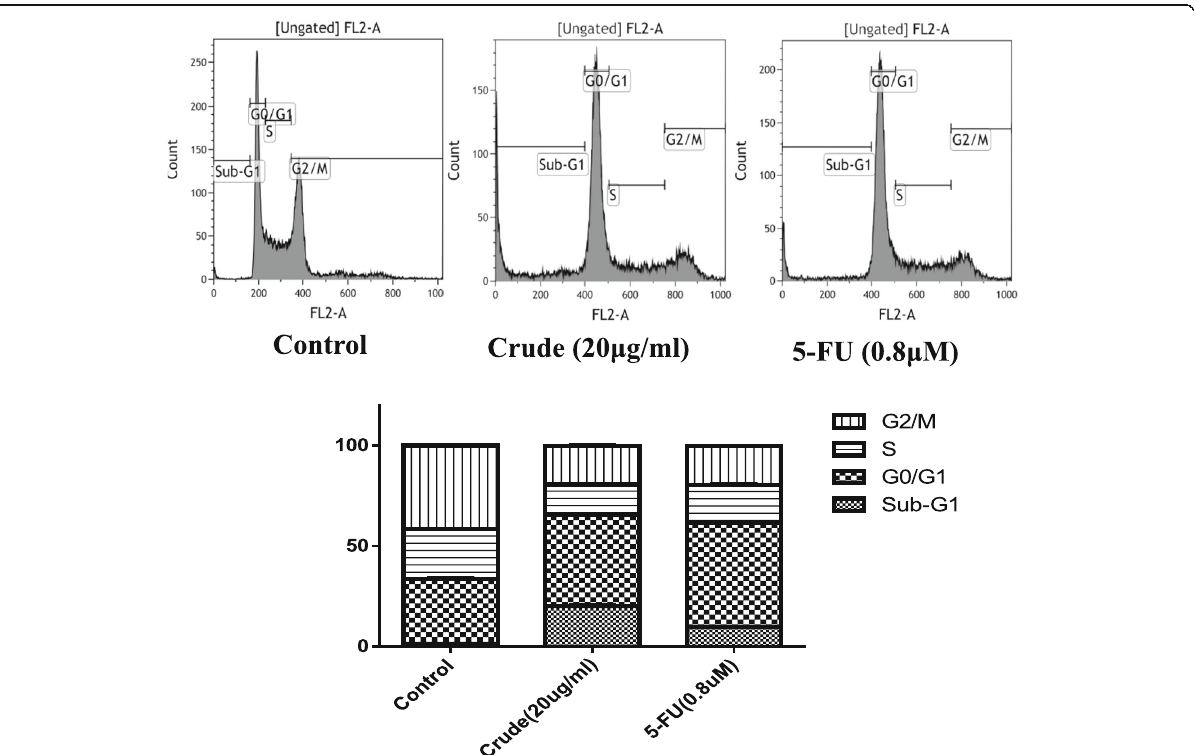
Fig. 3 Oral cancer G0/G1 arrest induced by the Danshen crude. Flow cytometry analysis results of crude- and 5-FU-treated SAS cells. The cells were treated with extract (20 μ g/mL) and 5-FU (0.8 μ M) for 24 h. Harvested cells were stained with propidium iodide